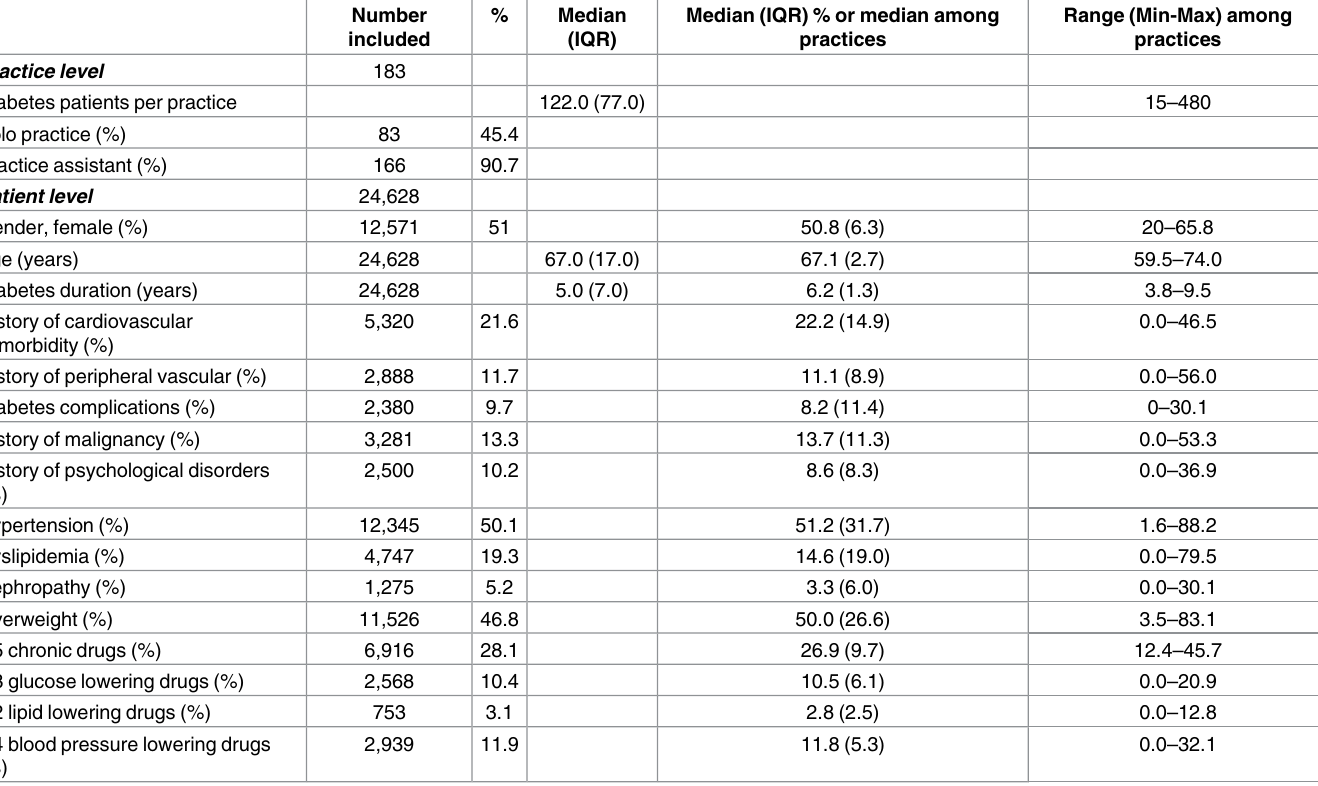
Table 1. Practice and patients’ characteristics for the study